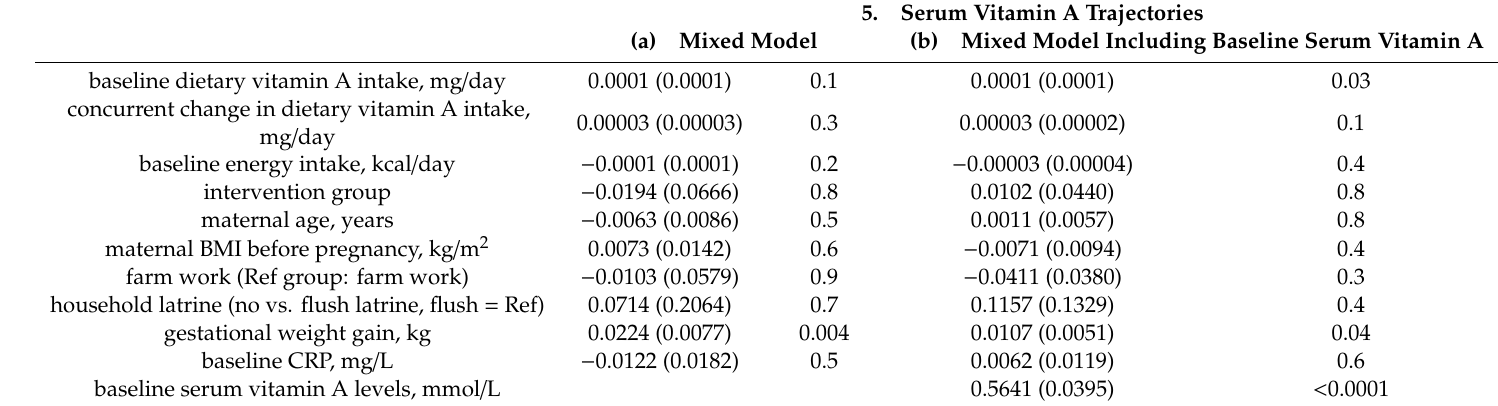
5. Serum Vitamin A